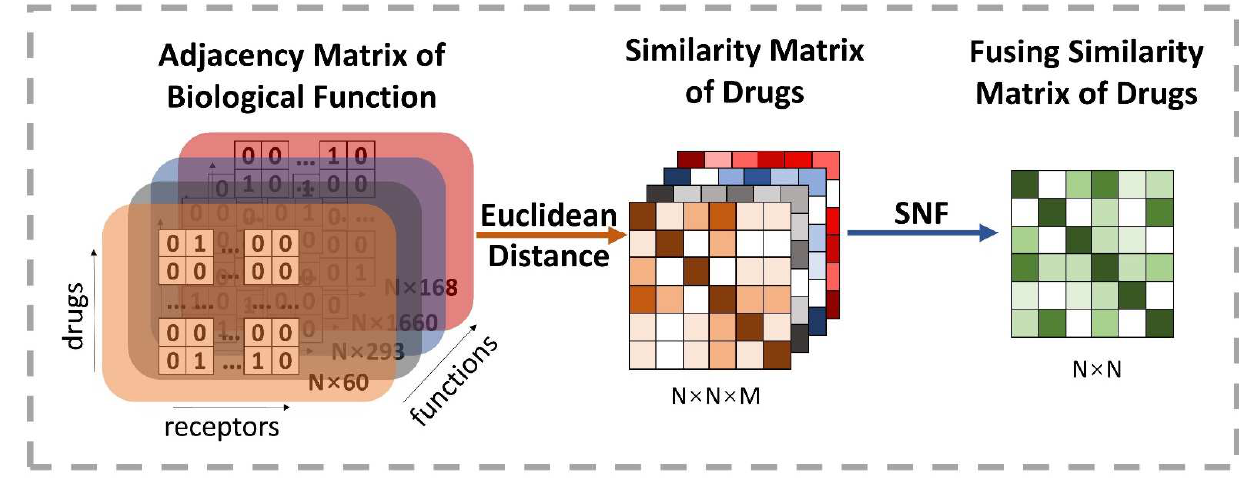
Figure 4. Illustration of the extracting process of the fusion drug similarity matrix. At first, M types of biological function information are used to construct adjacency matrixes, whose row indicates the drug’s initial vector and the number of receptors decides the dimension. Thus, each row is regarded as a high-dimensional space representation of drugs. Then, the drug similarity matrix based on different kinds of space can be obtained by calculating the Euclidean distance on each pairwise embedding vector of drugs. Finally, it exploits the SNF method to produce a comprehensive representation of the biological function information by fusing similarity matrixes of all types of space.